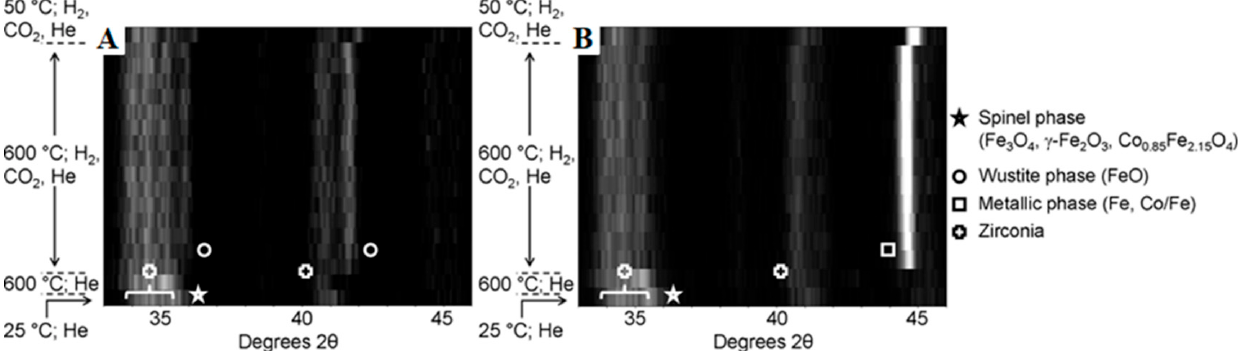
Figure 14. In situ XRD profiles of OCs reduced by 1 vol % H 2 /1 vol % CO 2 in He at 600 °C. ( A ) Fe 2 O 3 supported on m-ZrO 2 (ALD/20.2% mass loading) and ( B ) Co 0.85 Fe 2.15 O 4 supported on m-ZrO 2 (ALD/19% mass loading). Chemical reduction for 148 min. Adapted with permission from Ref. [162], copyright 2011, American Chemical Society.